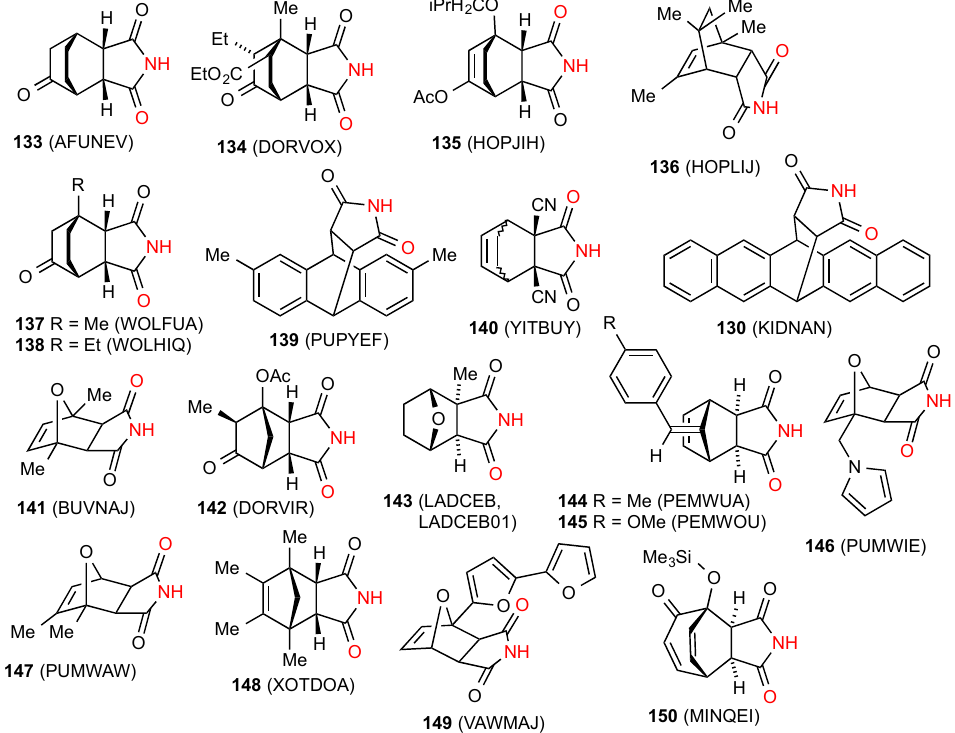
Figure 45. Bicyclo[2.2.1] and [2.2.2]-fused succinimides showing pattern B ribbons.